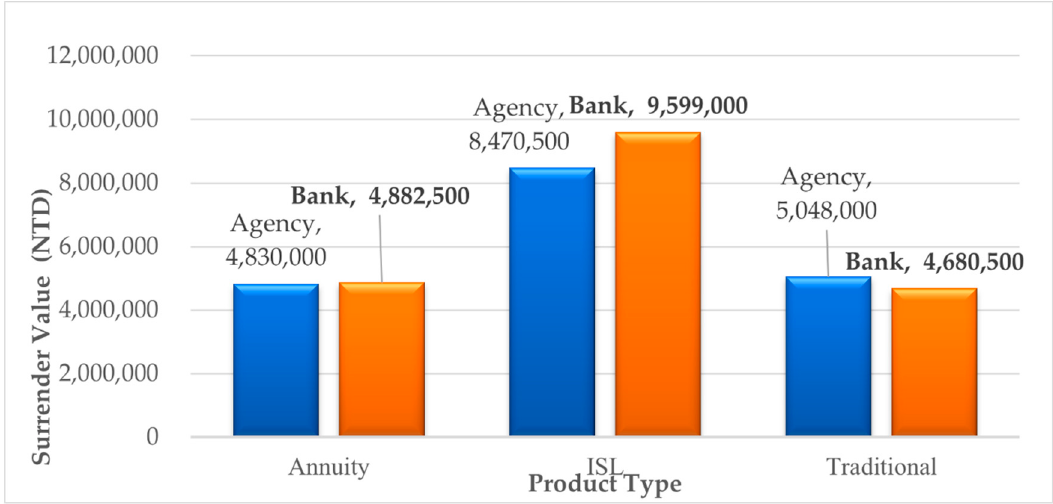
Figure 4. Example of pivot analysis charts for customers. Source: Micro-excel database built by the author to simulate the policyholder’s insurance database.